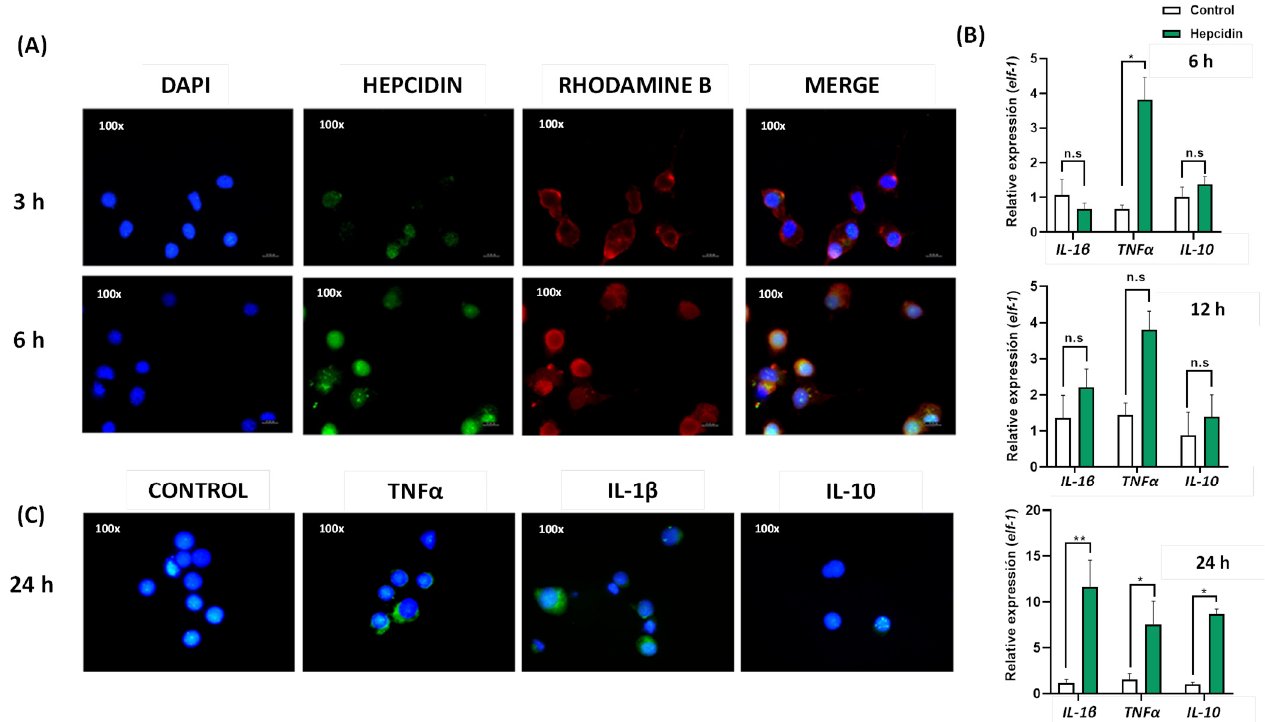
Figure 5. Effect of Hep20 on the expression of IL-10, IL-1 β , and TNF α cytokines in RTS-11 cell line. ( A ) RTS11 cells treated with Hep20. Hepcidin was detected using mouse-specific antiserum and the anti-mouse IgG Alexa-488 conjugated antibody (green). Octadecyl rhodamine B chloride (R18) was used for membrane staining (red). Moreover, DAPI was used as nuclei staining (blue). ( B ) Relative mRNA expression of IL-1 β , TNF α , and IL-10 mRNA in RTS-11 cell line treated with Hep20 for 6, 12, and 24 h. The mRNA expression is expressed as a fold-change over the control (non-treated cells). Data are presented as the mean ± standard error, with n = 4. * p < 0.05, ** p < 0.01 from Wilcoxon–Mann–Whitney non-parametric test; n.s (non-significant differences). ( C ) Detection of IL-1 β , TNF α , and IL-10 on RTS11 cells after 24 h post-treatment with Hep20. The cytokines were detected using mouse-specific antiserum and the anti-mouse IgG Alexa-488 conjugated antibody (green). Moreover, DAPI was used as nuclei staining (blue).